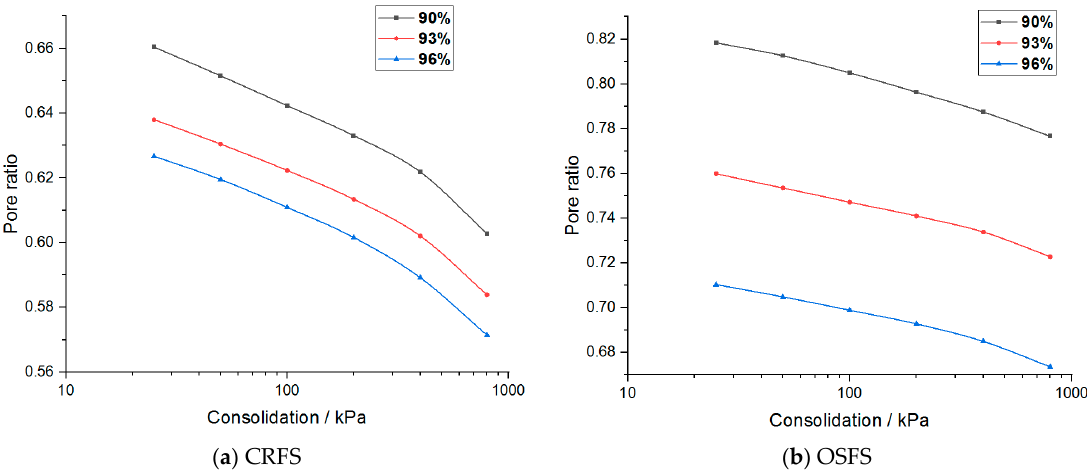
Figure 15. Logarithmic curve of pore ratio and stress of modified soil with different compaction degrees. Consolidated yield stresses of two kinds of modified soils can be obtained by the Casagrande plotting method. The horizontal line and tangent line are respectively made at the point of the maximum curvature of the curve, and then the angle bisector of the two lines is made to extend the straight line at the end of the porose-stress logarithmic curve and intersect the angle bisector. The abscess stress value corresponding to the intersection point is the consolidated yield stress of the soil sample. Consolidated yield stresses of the two modified soils with different water contents and compactness are shown in Tables 6 and 7. Table 6. Consolidation yield stress of modified soil with different water contents (kPa). Modified Soil